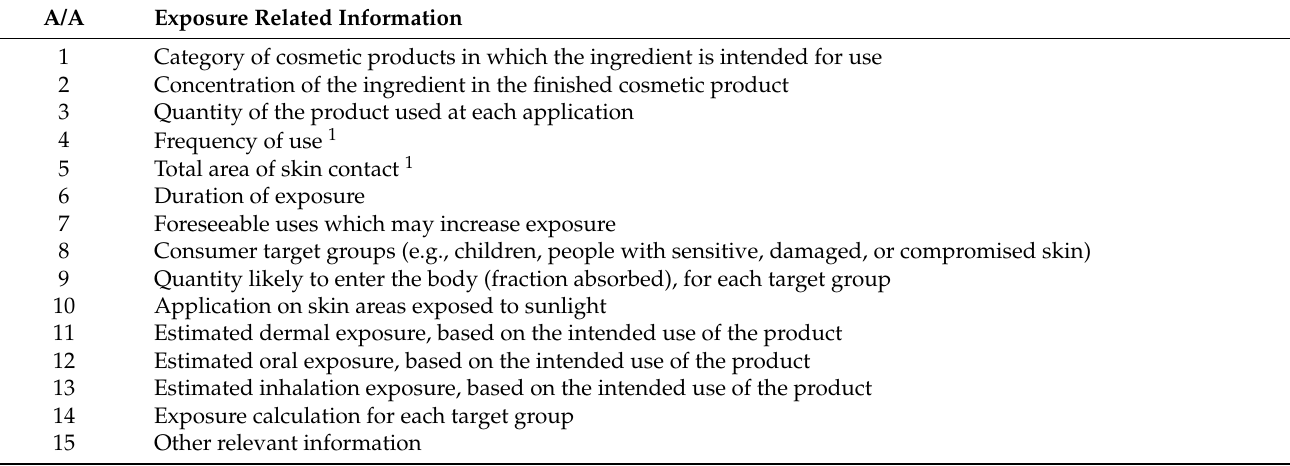
Table 4. Checklist for information on exposure